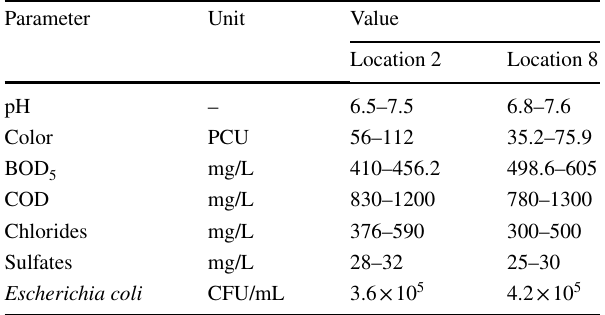
Table 2 Physicochemical characteristics of wastewater at location 2 and location